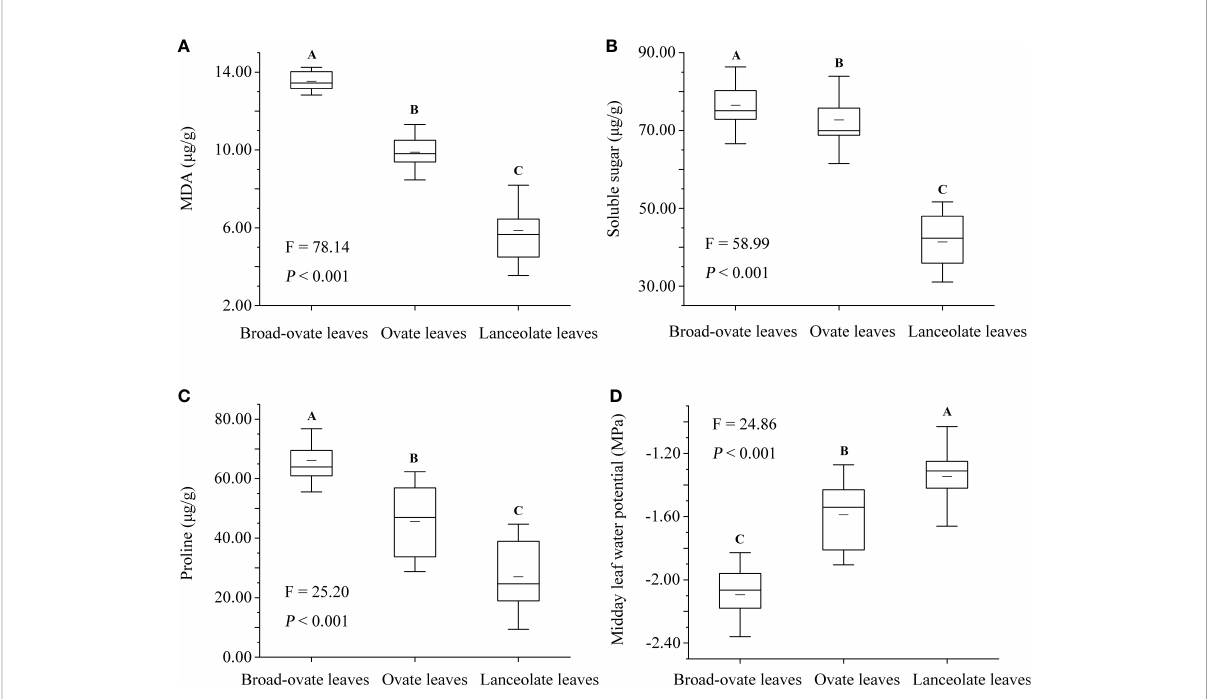
FIGURE 8 Differences in drought stress among the heteromorphic leaves. MDA is the abbreviation of malondialdehyde. The instructions of P , F , and other capital letters are shown in Figure